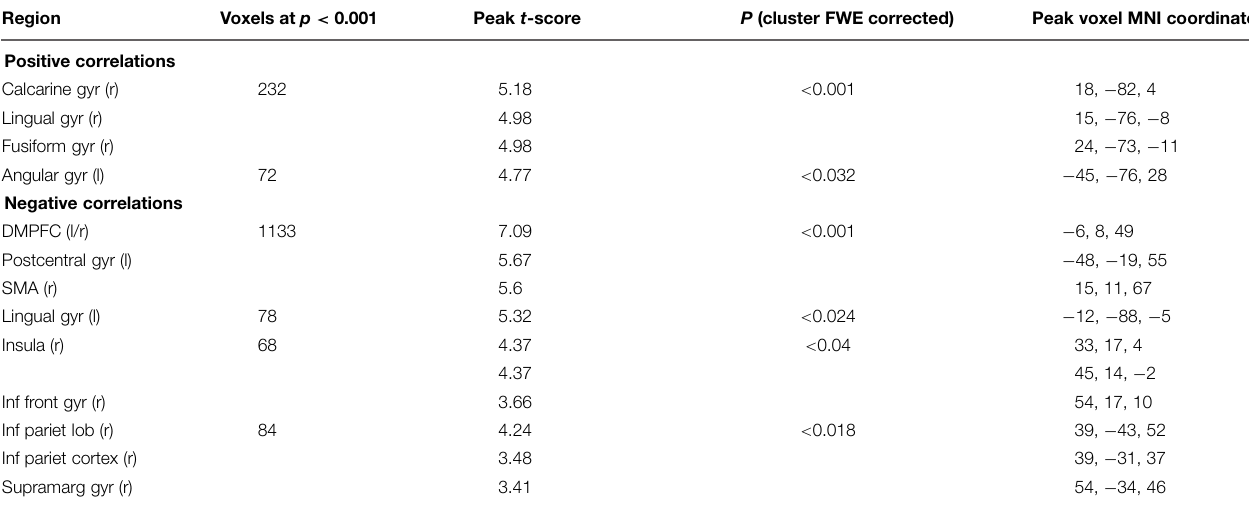
TABLE 4 | Conjunction: areas showing task-independent significant correlations with subjective certainty ratings in both color and motion trials. Region Voxels at p < 0.001 Peak t -score P (cluster FWE corrected) Peak voxel MNI